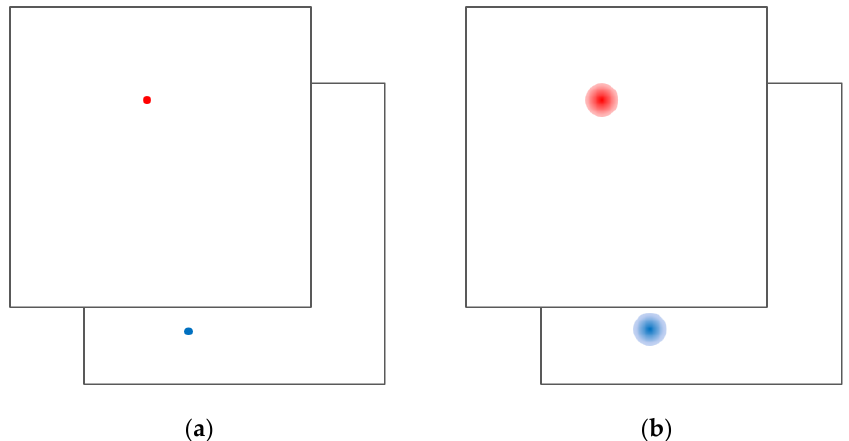
Figure 4. Multi-layer heatmaps for workpiece landmarks. ( a ) Landmarks. ( b ) Heatmaps.